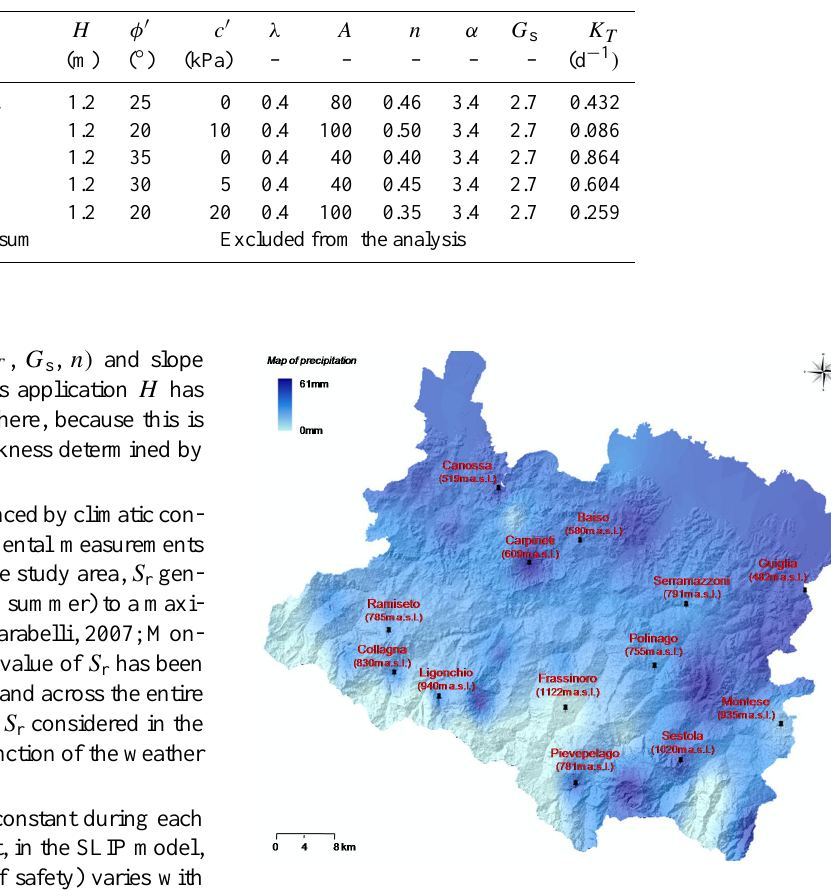
Fig. 8. Rain-gauge locations and example of rainfall distribution Figure 8 obtained after the application of the interpolation method on the study area for the rainfall event of the 11 April